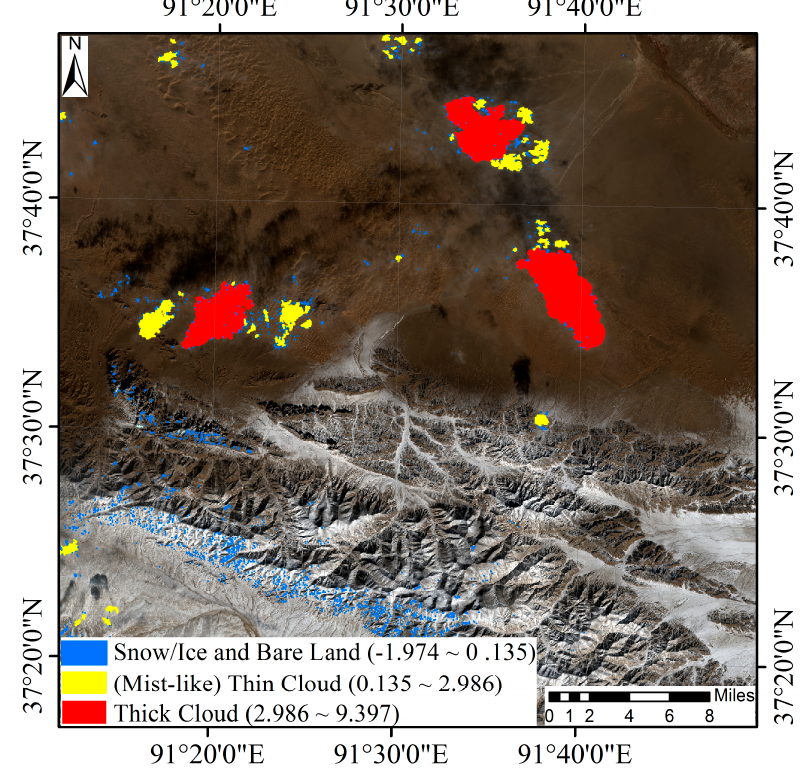
Figure 7. Output image of hotspot analysis based on the anomaly-overlaying between ROI 1 and ROI 2.